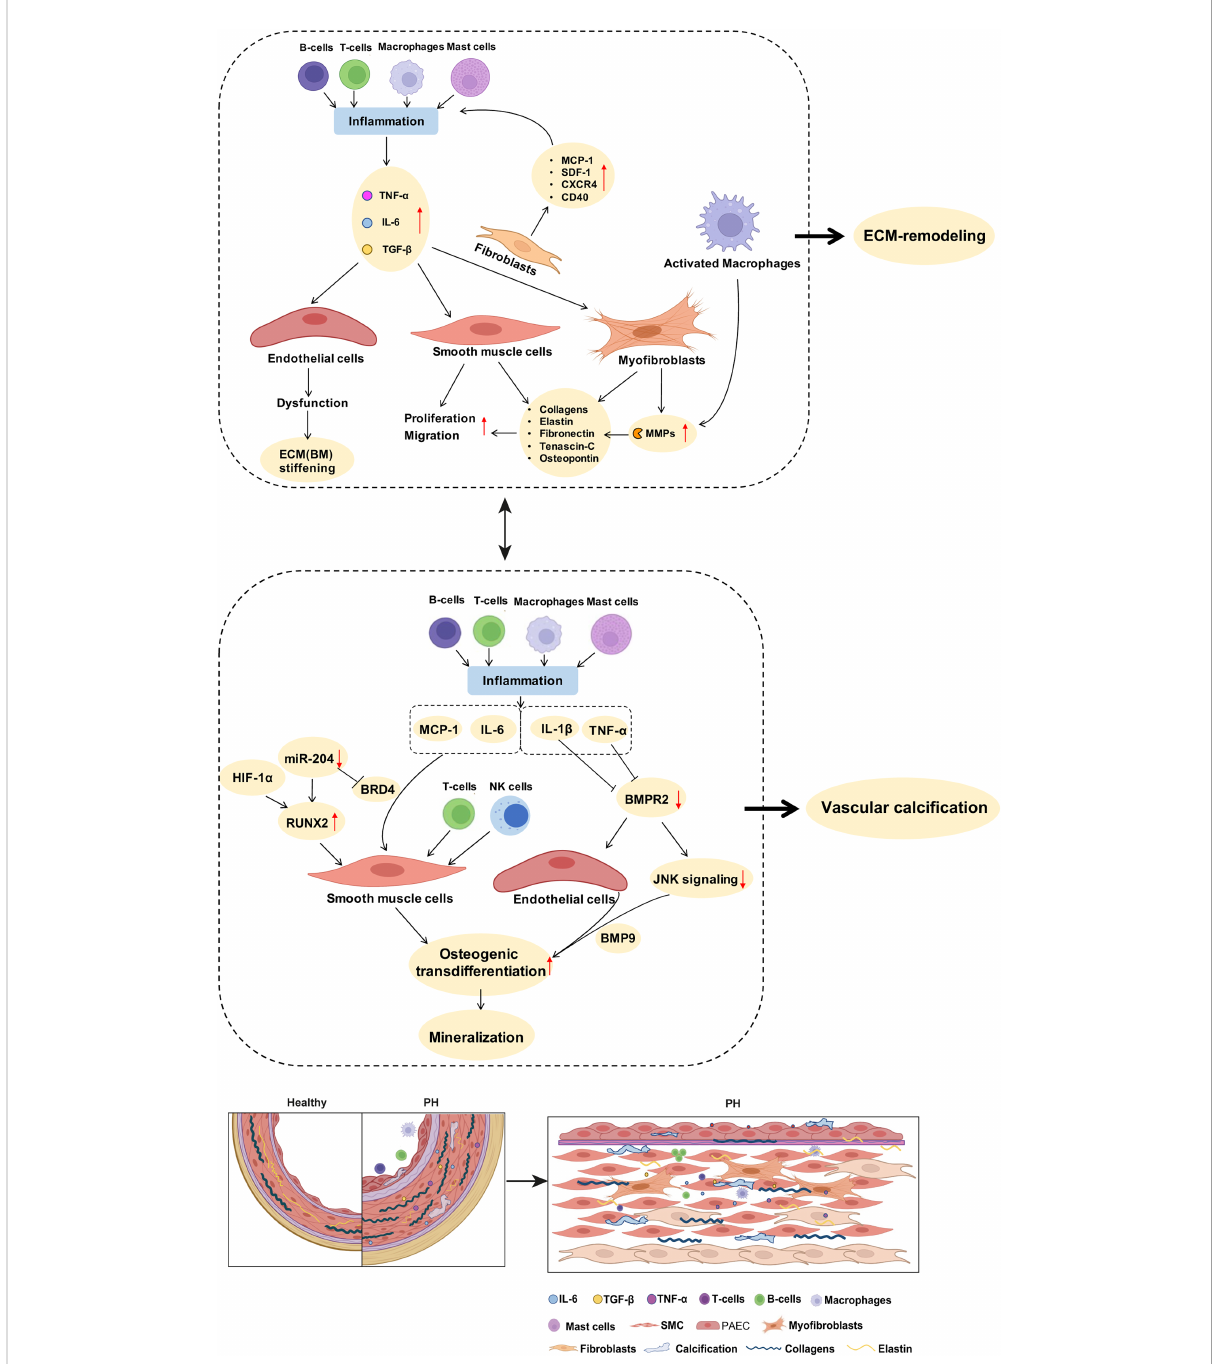
FIGURE 2 Potential links between in fl ammatory mediators and mechanisms of pulmonary arterial ECM remodeling and vascular calci fi cation in PH. As described in detail in the manuscript text, perivascular accumulation of immune cells is a characteristic feature of PH. In fl ammatory cells such as macrophages produce MMPs that promote ECM degradation and remodeling. In fl ammatory cytokines such as IL-6 and TGF- b drive the proliferation of PA SMCs. Stimulation of fi broblasts by in fl ammatory mediators increases the expression of collagens, elastin, and fi bronectin, further promoting PA stiffness. Activated immune cells and in fl ammatory mediators promote SMC transdifferentiation and enhance the expression of biomineralization genes, thus driving vascular calci fi cation. BMPR2 downregulation, especially in response to the in fl ammatory factor TNF, promotes endothelial cell mesenchymalization and may as such contribute to the development of pulmonary vascular calci fi cation. A detailed discussion of the proposed signaling pathways is provided in the manuscript text. ECM, extracellular matrix; MMPs, matrix metalloproteinases; SMC, smooth muscle cells; PH, pulmonary hypertension; PA, pulmonary artery; BM, basement